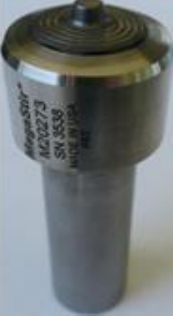
Figure 3. Megastir Q70 (PCBN/WRe) tool.